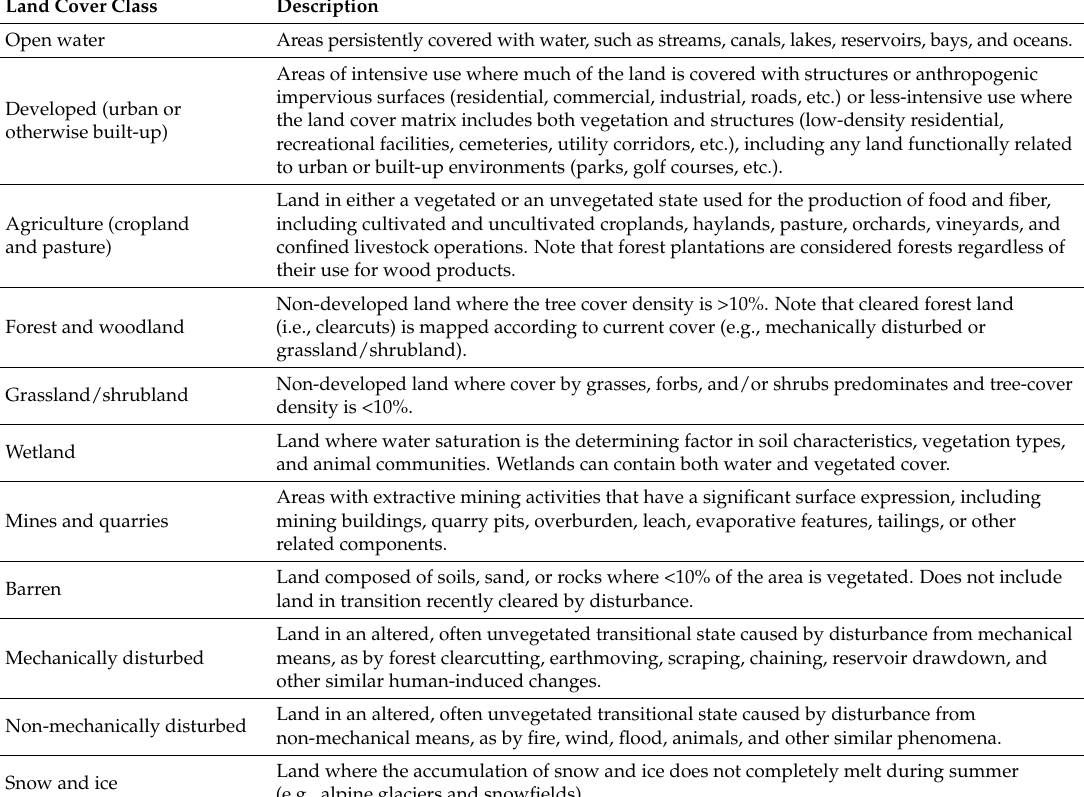
Table 1. Land use/land cover classes and descriptions used by the U.S. Geological Survey, Land Cover Trends